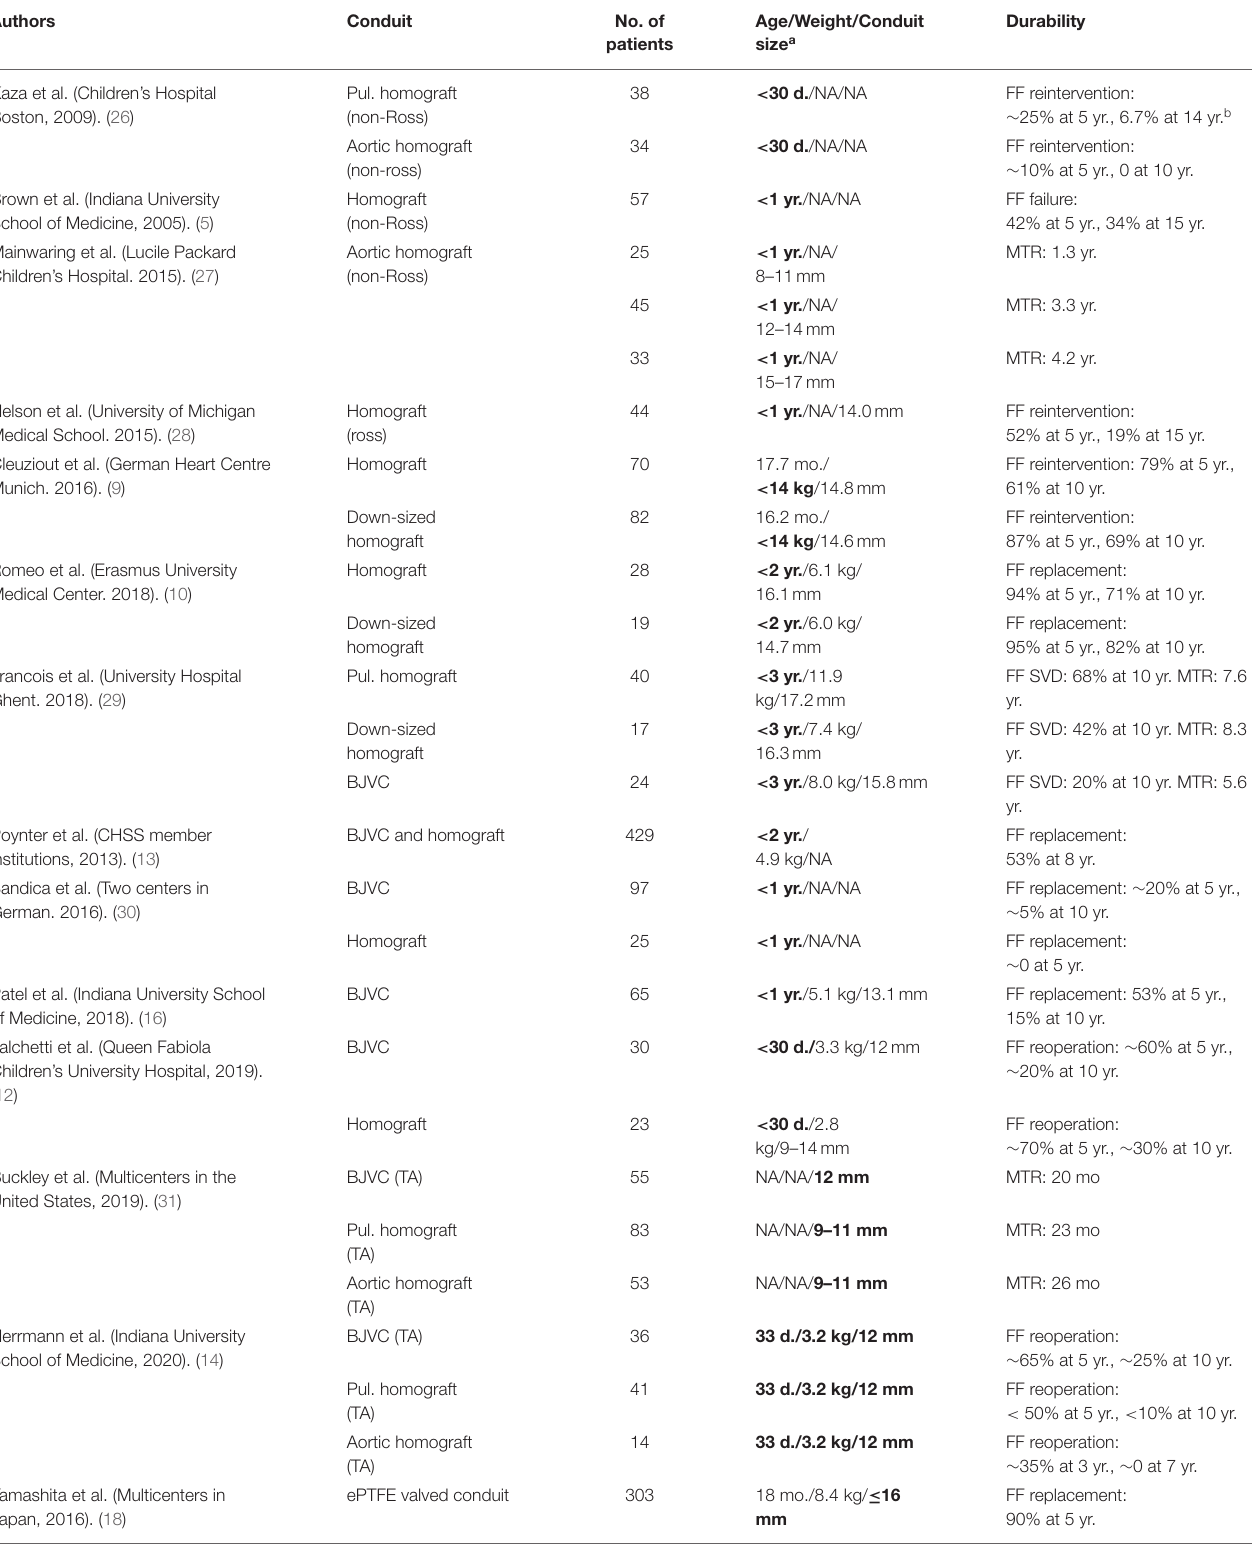
TABLE 1 | Clinical results of small-sized valved conduits for right ventricular outflow tract reconstruction in infants and young children. Authors Conduit No. of